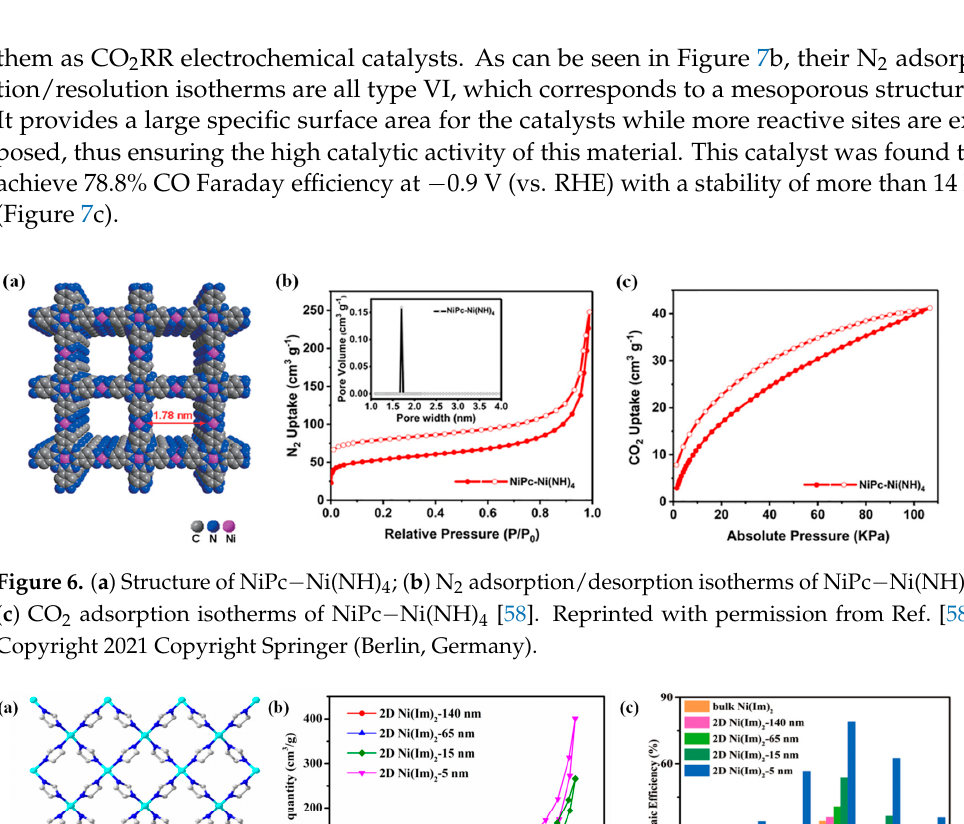
Figure 7. ( a ) Structure of 2D Ni(Im) 2 ; ( b ) N 2 adsorption/desorption isotherms; ( c ) Potential − depend- ent Faradaic efficiencies of CO [59]. Reprinted with permission from Ref. [59]. Copyright 2019 Cop- yright Royal Society of Chemistry (London,